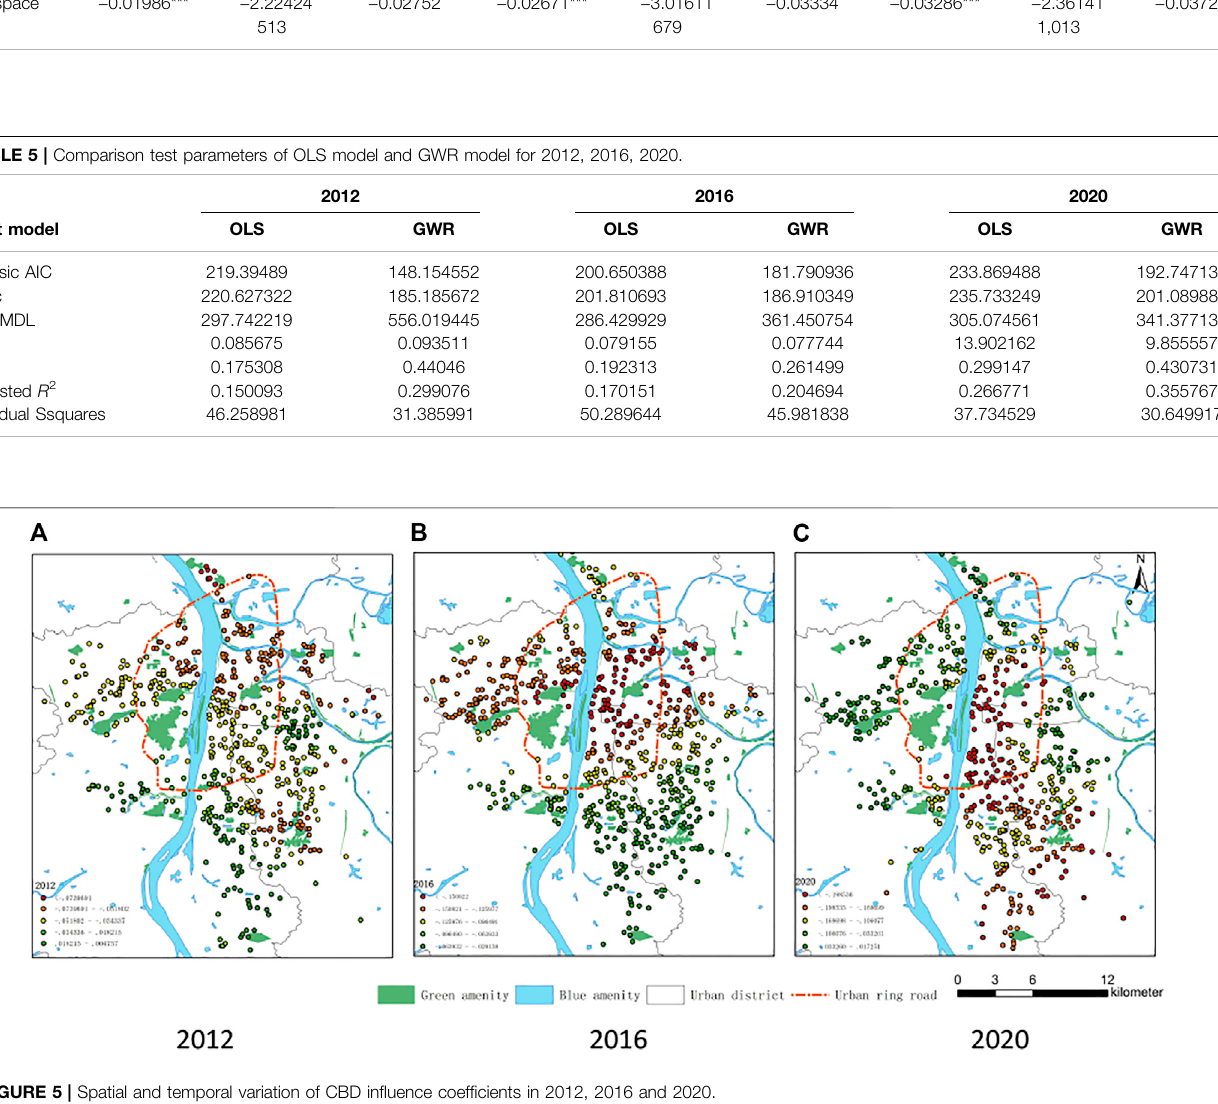
Frontiers in Environmental Science |